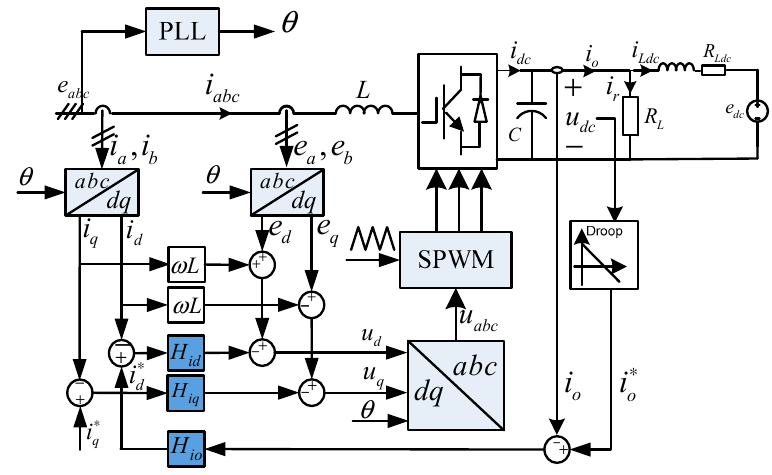
Figure 3. Unified control scheme of the three phase bidirectional converter.